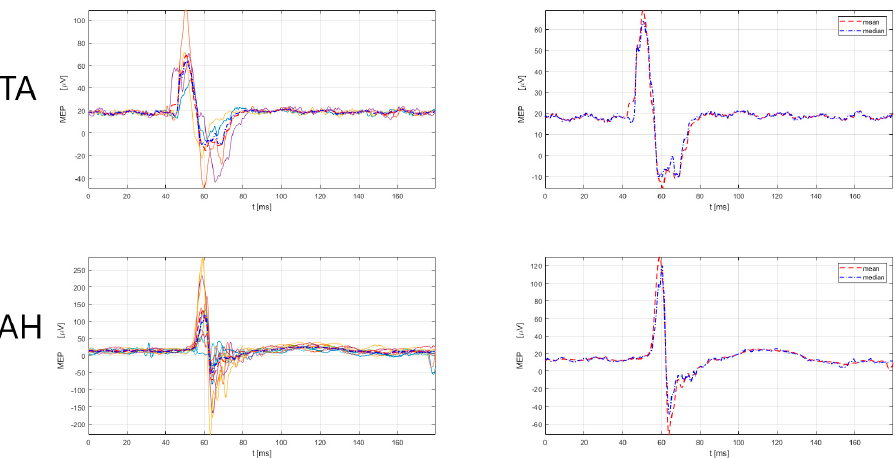
Figure 6. MEP responses for lower extremity (TA, AH) muscles, right side for No5 subject. Left: superimposed responses, Right: mean and median responses. TA = tibialis anterior, AH = abductor hallucis. Legend: the red dashed line denotes the mean response of all MEPs, and the blue dash- dotted line represents the median response of all MEPs. MEP latency and amplitude estimation was performed by a custom-made Matlab script (R2021a) using an automatic algorithm, developed by Šoda et al. (2020) [68].